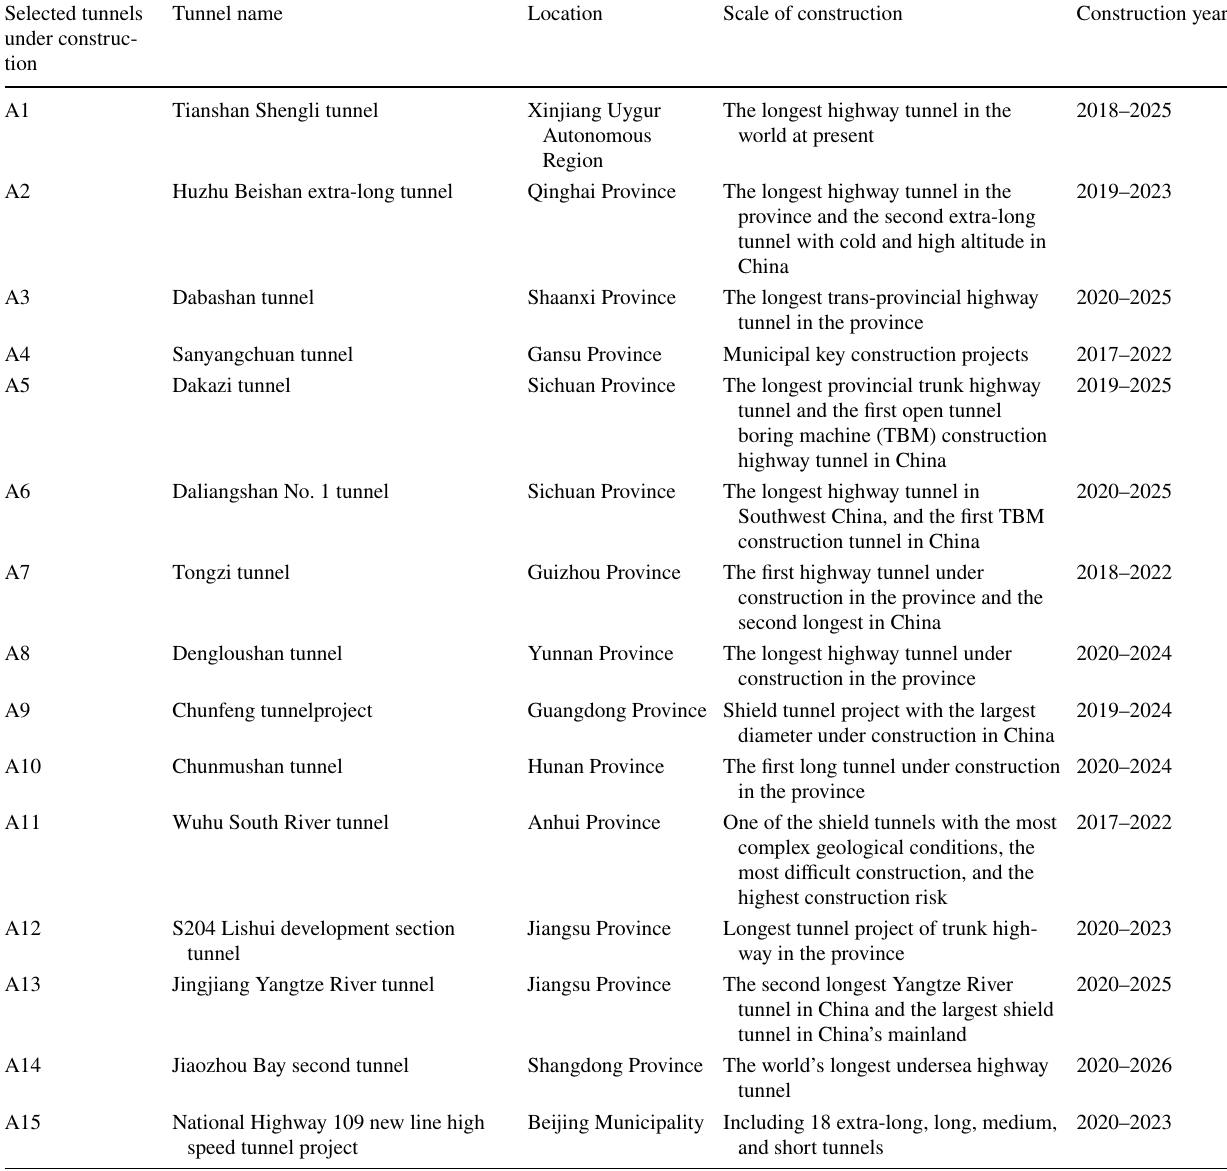
Table 3 Specific conditions of selected highway tunnels under construction Selected tunnels under